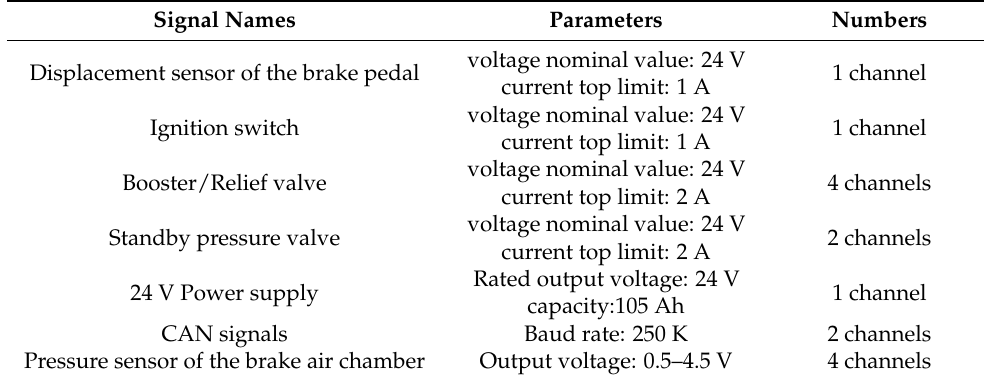
Figure 5. Hardware logic block diagram of the EBS bottom controller based on the EPV module. Table 1. External interface and relevant parameters of the bottom